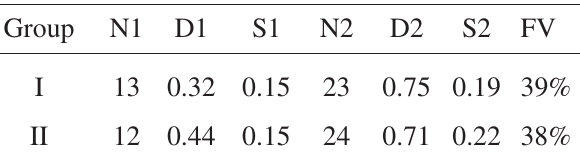
Table II. Cold events classification results. N1,